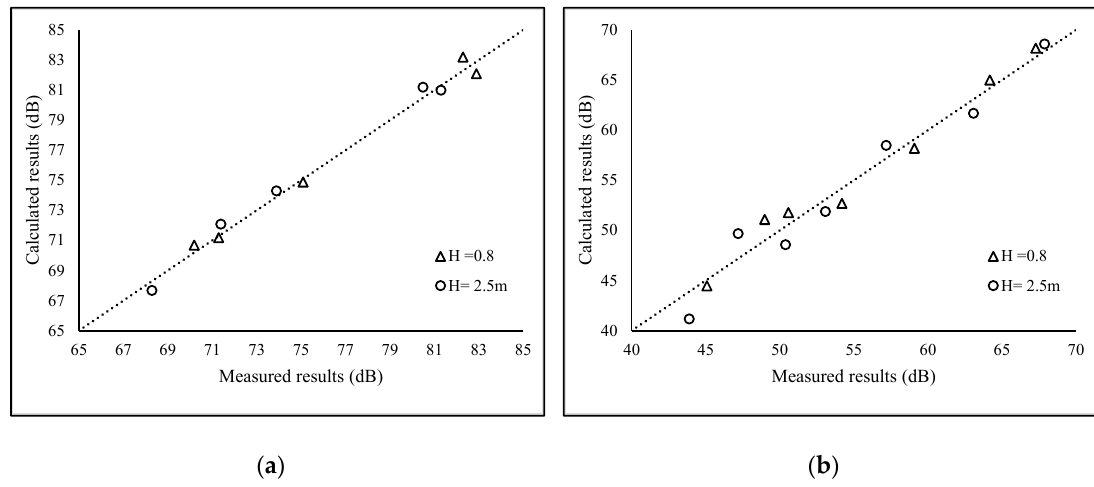
Figure 4. The correlation analysis of the measured and calculated data. ( a ) H = 0.8 m; ( b ) H = 2.5 m.